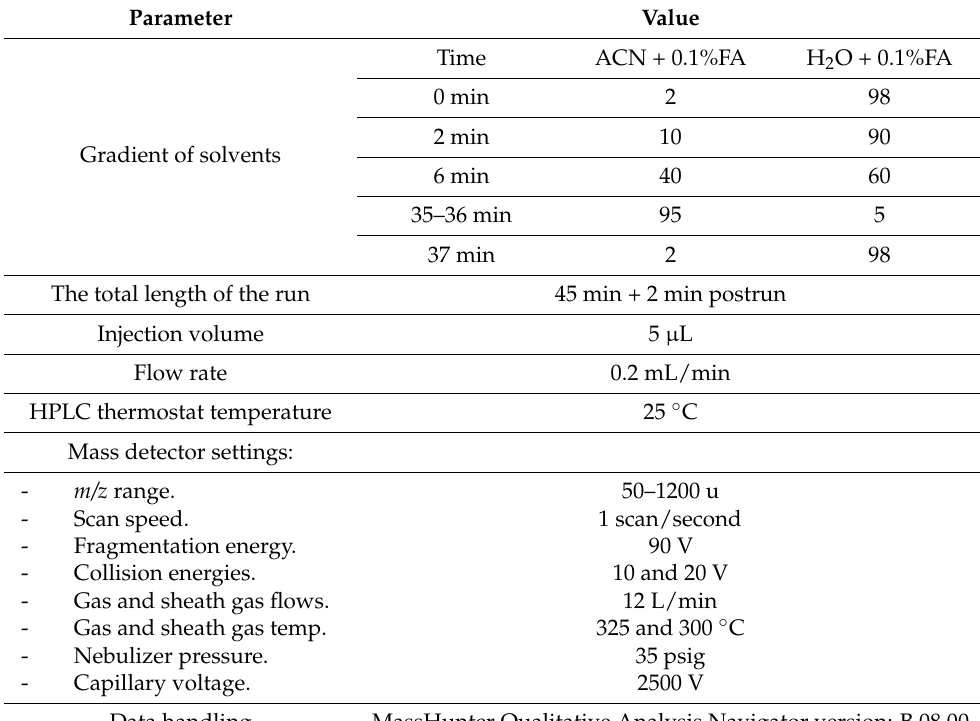
Table 2. The chromatographic parameters set for the qualitative analysis of the tested samples of PHT-MLT powder and SNT-MLT ( ACN—acetonitrile, FA—formic acid